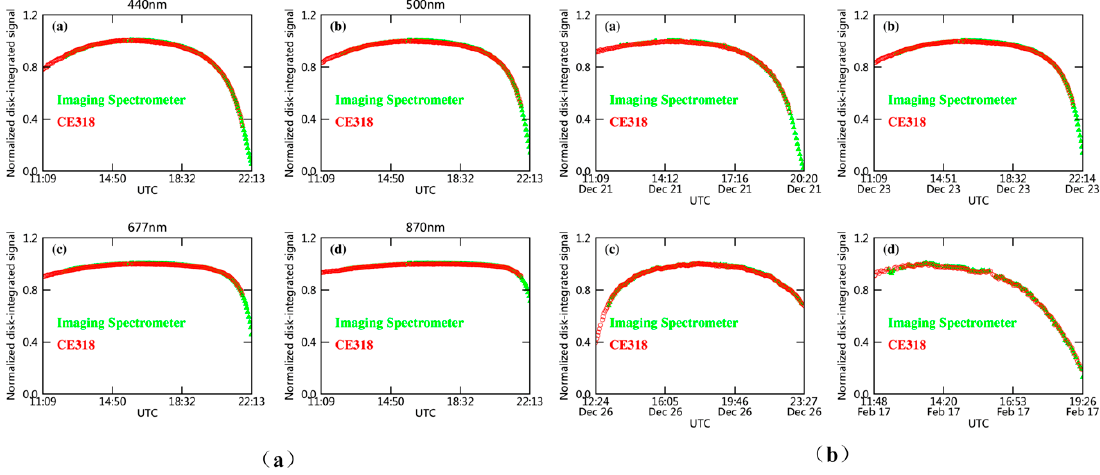
Figure 5. Lunar cross-comparison of CE-318U and imaging spectrometer. ( a ) Lunar cross-comparison in di ff erent wavelengths on December 24, 2015. ( b ) Lunar cross-comparison in the di ff erent days at 500 nm. The phase angle in ( b ) near the zenith is − 51 ◦ , − 24 ◦ , 17 ◦ , and 61 ◦ , respectively. The ordinate is the normalized disk-integrated signal.